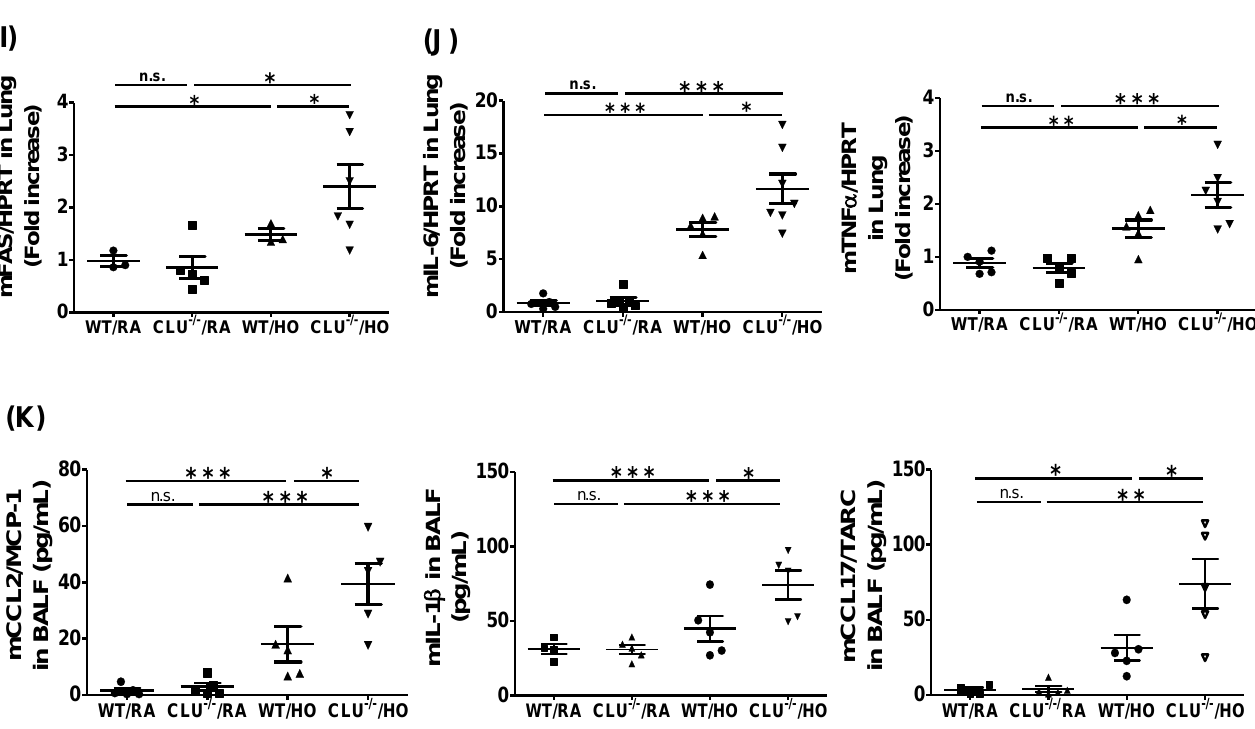
Figure 2. Clusterin (CLU) deficiency exacerbates hyperoxia-induced lung injury. Wild-type (WT) and CLU-deficient (CLU − / − ) mice were exposed to >95% O 2 and ( A ) survival, ( B ) lung tissue injury (assessed by light microscopy, H&E staining), ( C ) BALF total cell recovery and ( D ) BALF protein ( E ) LDH and ( F ) 8-OH-dG levels were assessed. ( G ) TUNEL staining of lung tissue sections. Sections were stained with TUNEL (green) and DAPI (blue). ( H ) Caspase-3/7, -8 and -9 activities were measured in the lung lysates. The mRNA levels of ( I ) Fas and ( J ) IL-6 and TNF- α were detected by real-time PCR. ( K ) CCL2, IL-1 β and CCL17 expression levels were determined in BALF. The data represent assessments in a minimum of n = 5 mice. Each symbol in dot plot graph represents the value for every mouse. Scale bars in ( B ): 100 µ m; Scale bars in ( G ): 50 µ m; n.s. = not significant; * p < 0.05, ** p < 0.01, *** p <